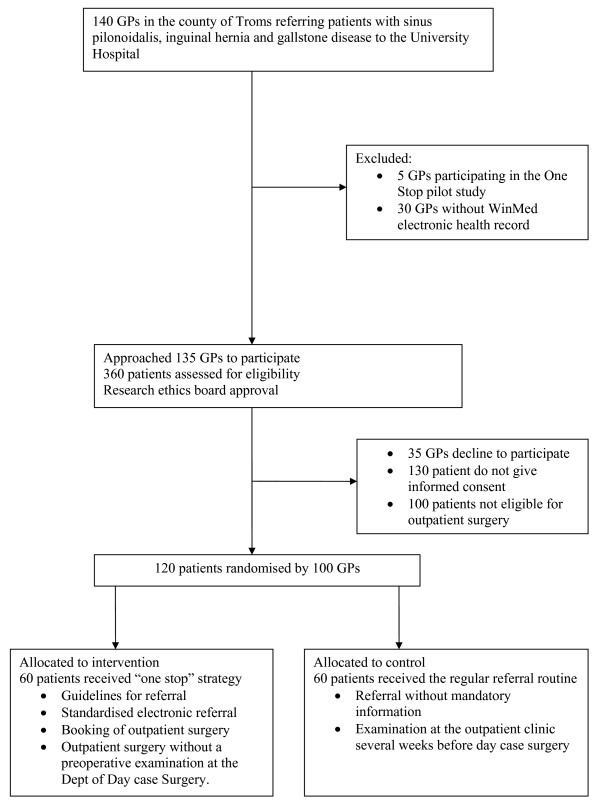
Trial flow chart.